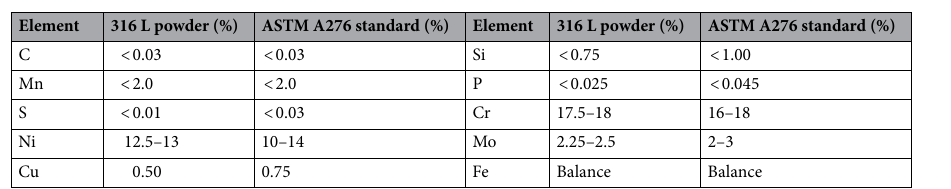
Table 1. The comparison of powder material manufactured in SANDVIK osprey and ASTM A276 standard.